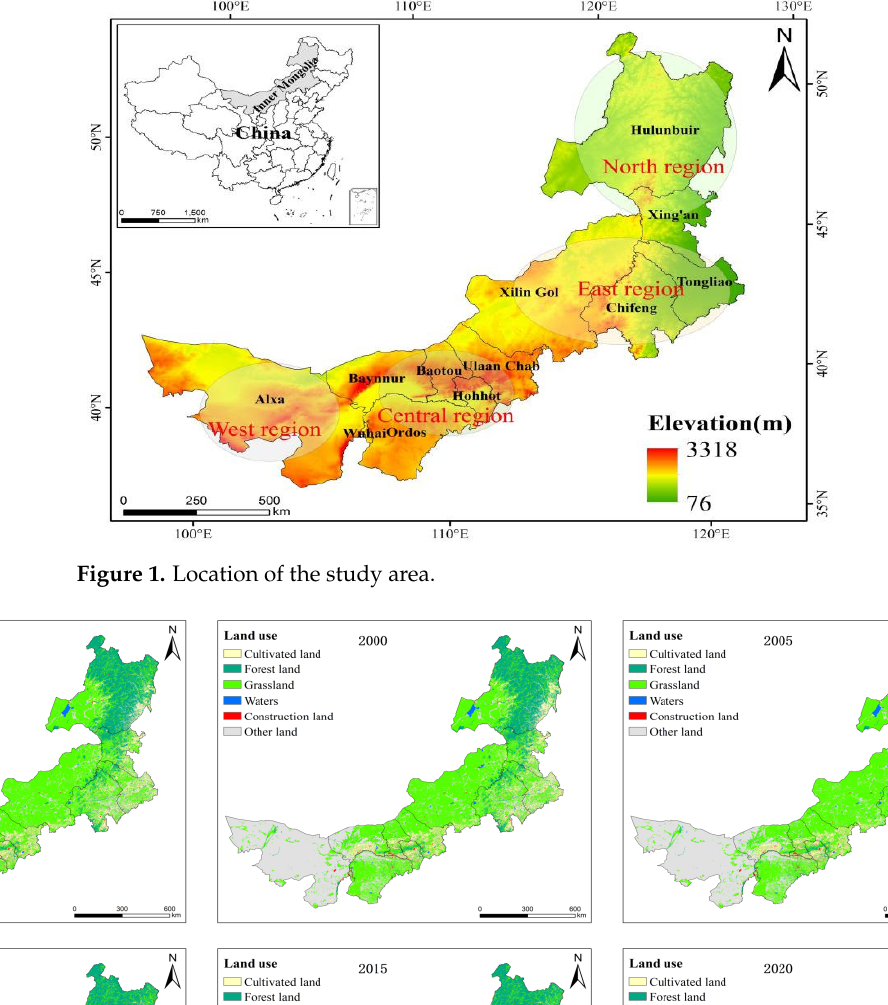
Figure 1. Location of the study area.